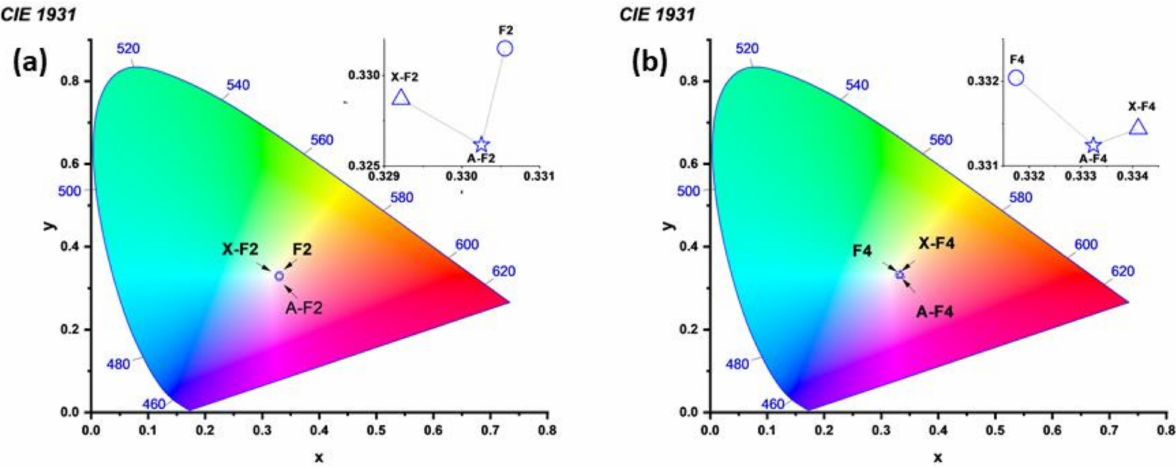
Figure 7. CIE Lab space evaluation of UV-Vis data from samples generated during modification of fabrics: analysis of fabric 2 ( a ) and fabric 4 ( b